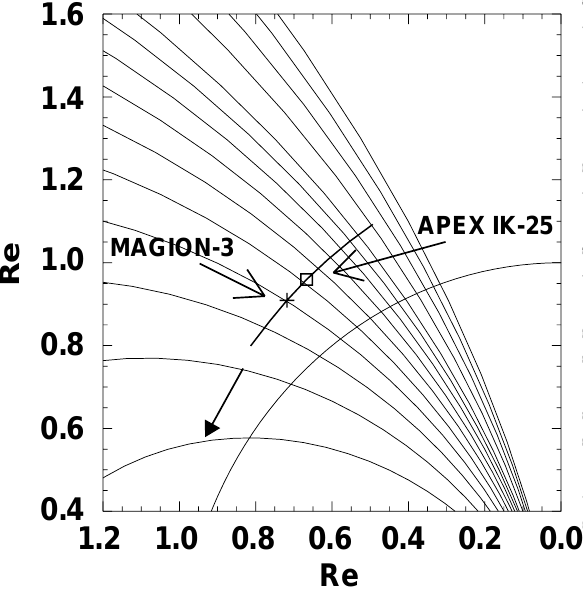
Fig. 6. Schematic plot of satellite positions during electron burst